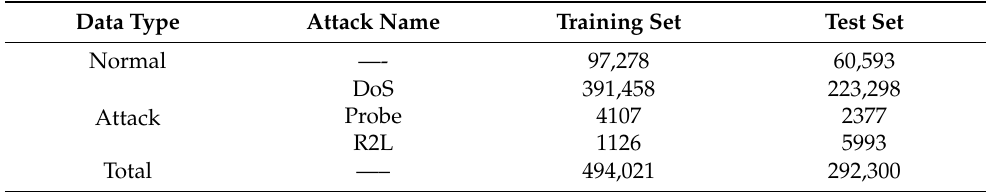
Table 2. KDD Cup99 dataset details.(Data from Liu and Jianbiao Zhang [19], Discrete Dynamics in Nature and Society, published by Hindawi, 2020).